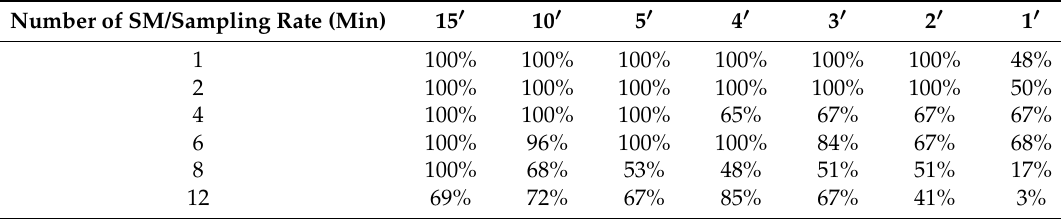
Table 5. Results summary-variable: number of readings